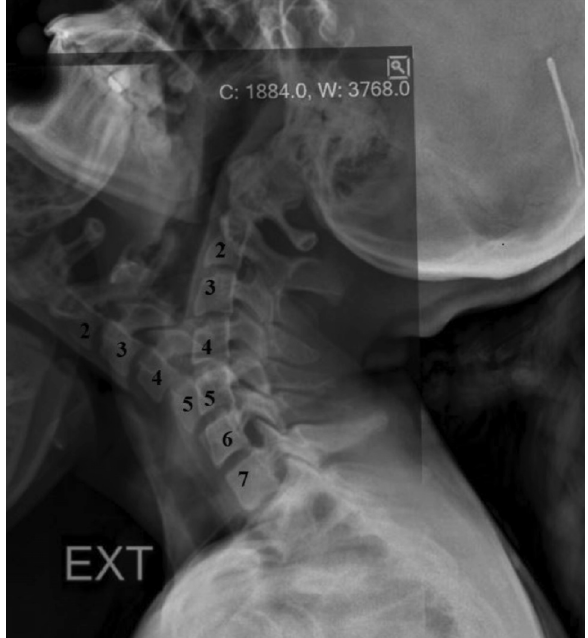
Fig. 2: The ICR detection for the C6-C7 segment of the patient in the Fig 1. The ICR was localised at the intersection of the vertices from the midpoint of the two lines. The two lines were formed by the four dots on the anterior and posterior corner of C6 vertebrae in flexion and extension